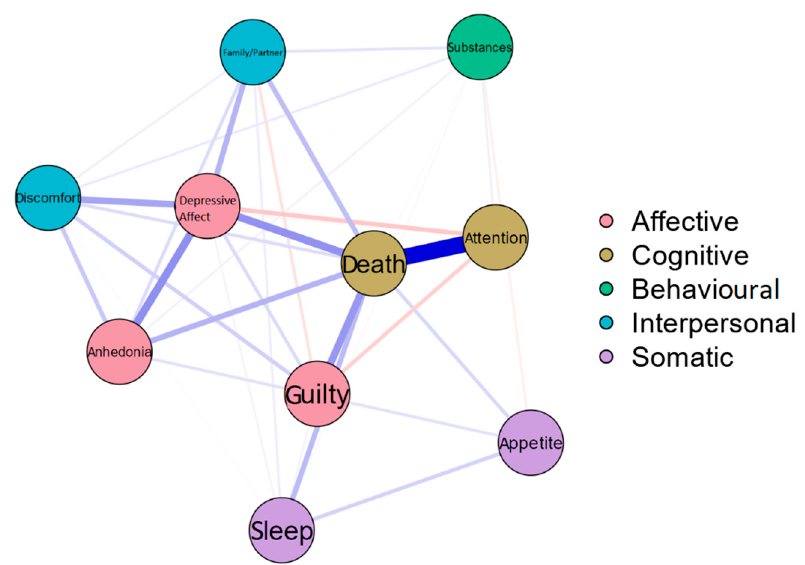
Figure A4. Estimated correlation network for the factors evaluated with the DCET (temporal mo- ment ‘always’). Note — The most central nodes are “death” and “depressed mood”. The strongest relationship is established between “thoughts of death” and “attention”. It should be noted that some negative relationships are established in this network; although, they are quite weak.